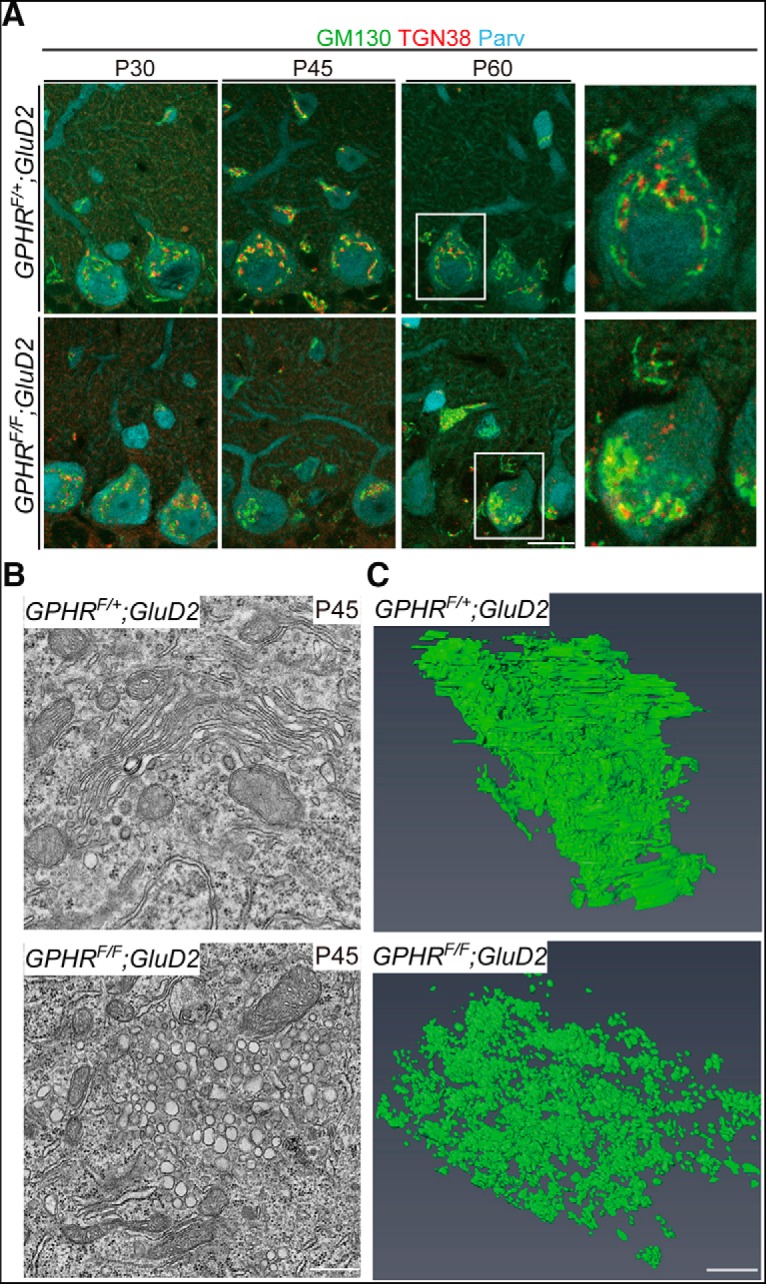
Deletion of GPHR has an effect on the Golgi apparatus organization and distribution in PCs. A, Triple immunofluorescence for GM130 (cis-Golgi; green), TGN38 (trans-Golgi; red) and parvalbumin (Parv; cyan) in PCs from GPHRF/+;GluD2-Cre and GPHRF/F;GluD2-Cre mice at P30, P45, and P60. Scale bar: 20 µm. B, Ultrastructural analysis of Golgi apparatus structures in PC somata from GPHRF/+;GluD2-Cre and GPHRF/F;GluD2-Cre mice at P45. Typical Golgi apparatus structures with flattened cisterns in GPHRF/+;GluD2-Cre mice were distinguishable from the Golgi apparatus structures with clusters of vacuoles in GPHRF/F;GluD2-Cre mice. C, The Golgi apparatus structure reconstructed from serial FIB/SEM images in PCs from GPHRF/+;GluD2-Cre and GPHRF/F;GluD2-Cre mice at P45. 3D model shows that fragmentation of the Golgi apparatus occurred in PCs from GPHRF/F;GluD2-Cre mice. Scale bars: 500 nm. For A, B, three mice per genotype were used; n = 5 sections per mouse; representative images are shown. See also Movies 1, 2.